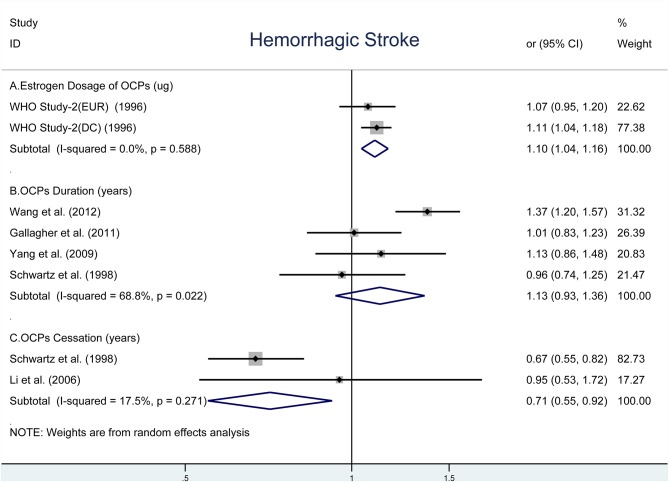
Forest plot of studies examining the association between OCP use [(A) estrogen dosage of OCPs, (B) OCPs duration, (C) OCPs cessation] and risk of hemorrhagic stroke.